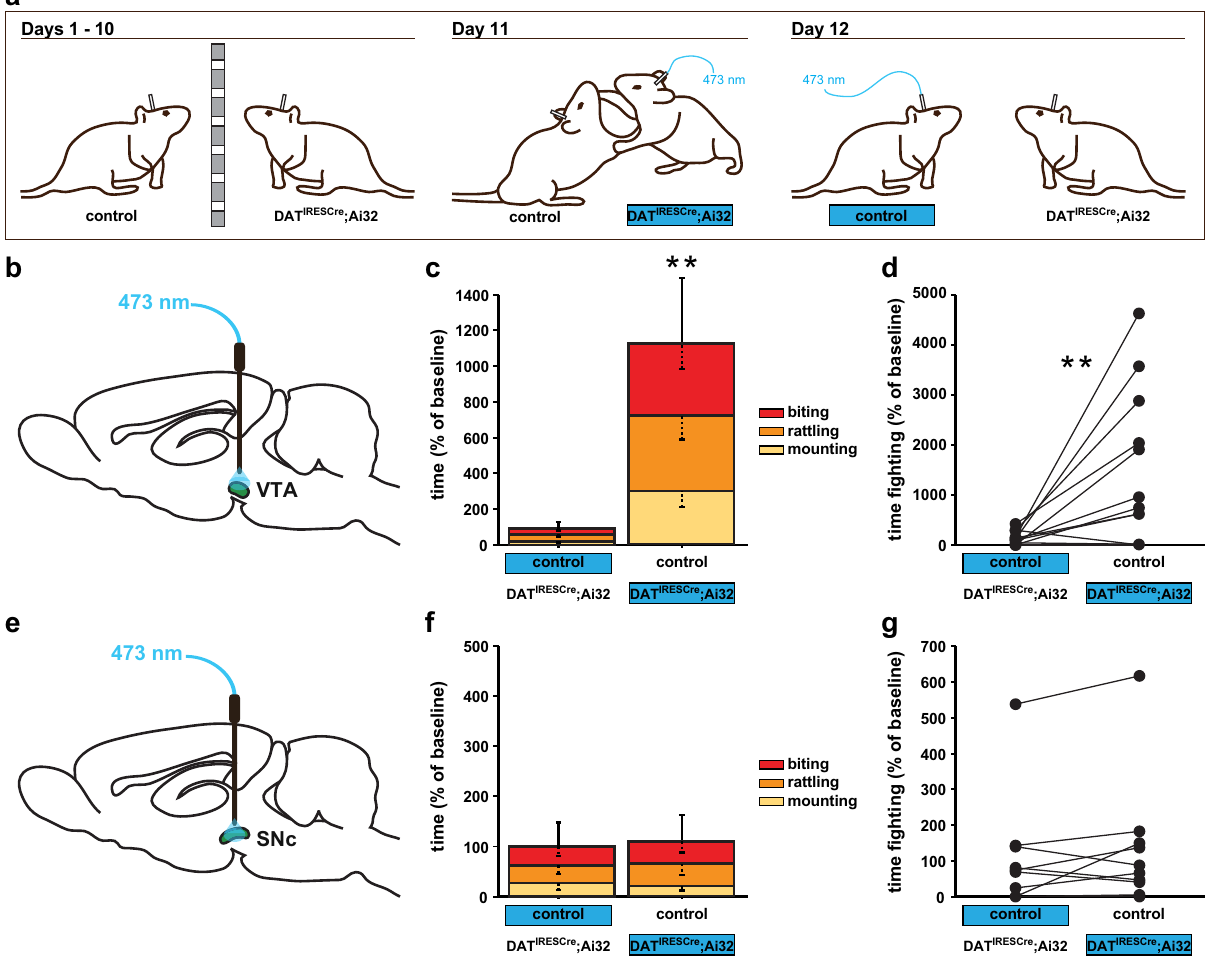
Fig. 1 Optogenetic activation of DAergic VTA, but not SNc, neurons increases aggression. a Schematic of the isolation-induced aggression experimental design between males. After separation for 10 days, mice underwent a stimulation protocol, counterbalanced for genotype on Day 11 and 12. Effects of optogenetic activation of the VTA ( b – d ) or SNc ( e – g ) on aggression. b The schematic diagram for stimulating VTA DA neurons in vivo. c , d Heightened aggressive behavior, measured as increased time fi ghting, was observed in pairs when DAT IRESCre ; Ai32 mutant mice were stimulated (blue). e The schematic diagram for stimulating SNc DA release in vivo. f , g No effect of SNc DA stimulation was detected. * P < 0.05; ** P < 0.01 compared with their respective controls; mean ± SEM; n = 16 ( c , d ) and 10 ( f )